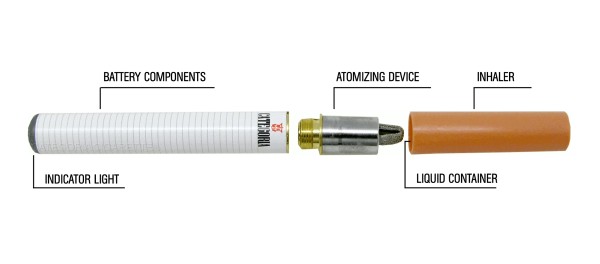
Structure of the 'Categoria' electronic-cigarette (e-Cigarette). The e-Cigarette is a battery-powered electronic nicotine delivery device (ENDD) resembling a cigarette designed for the purpose of providing inhaled doses of nicotine by way of a vaporized solution to the respiratory system. This device provides a flavor and physical sensation similar to that of inhaled tobacco smoke, while no smoke or combustion is actually involved in its operation. It is composed of the following key components: (1) the inhaler - also known as 'cartridge' (a disposable non-refillable plastic mouthpiece - resembling a tobacco cigarette's filter - which contains an absorbent material that is saturated with a liquid solution containing nicotine); (2) the atomizing device (the heating element that vaporizes the liquid in the mouthpiece and generates the mist with each puff); (3) the battery component (the body of the device - resembling a tobacco cigarette - which houses a lithium-ion re-chargeable battery to power the atomizer). The body of the device also houses an electronic airflow sensor to automatically activate the heating element upon inhalation and to light up a red LED indicator to signal activation of the device with each puff. Each pre-filled 'Original' cartridges used in this study contains nicotine (7.25 mg/cartridge) dissolved in propylene glycol (233.7 mg/cartridge) and vegetable glycerin (64.0 mg/cartridge) [details can be found at: http://www.liaf-onlus.org/public/allegati/categoria1b.pdf].